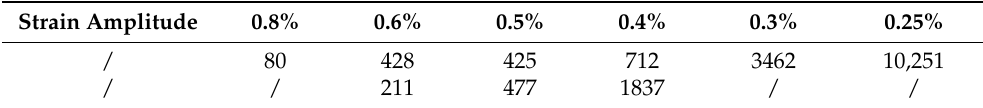
Figure 7. S-N curves of SAAM high-strength low-alloy steel workpieces along the vertical direction in low-cycle fatigue tests. Table 3. Fatigue test data of the SAAM high-strength low-alloy steel workpieces under different strain